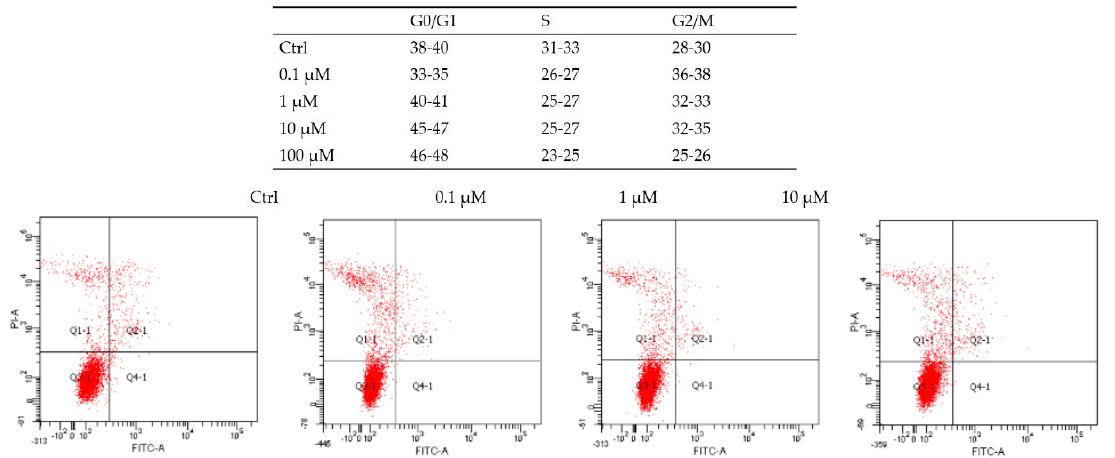
Figure 7. Cell viability assay (WST-1) in MDA-MB-231 cells after 48 h of incubation with compound 1 at the reported concentration. Values indicate the mean of three independent experiments and are expressed as percentage compared to control cells, error bars indicate the corresponding standard deviations values.